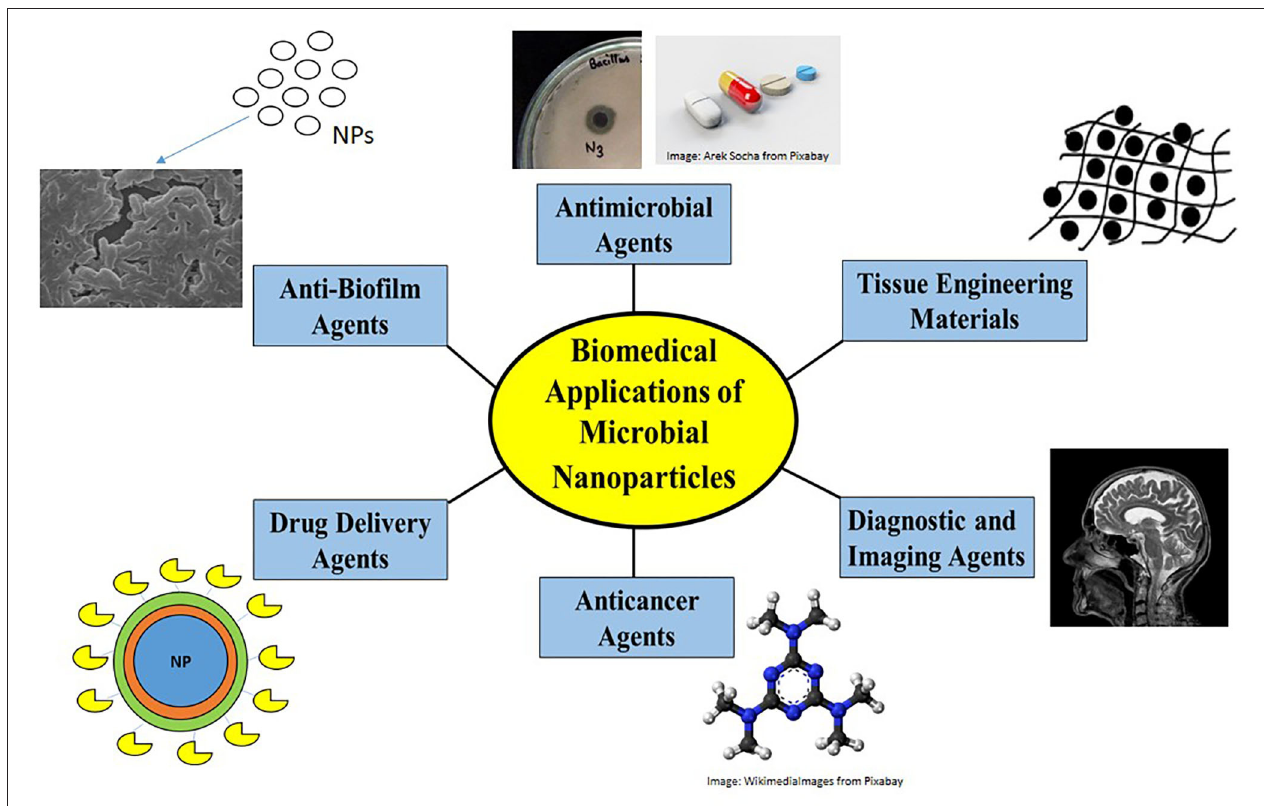
FIGURE 3 | Biomedical applications of nanoparticles. Nanoparticles find biomedical applications as antimicrobial agents by disrupting membrane structure or by generating ROS, as anti-biofilm agents in preventing antimicrobial resistance, as drug-delivery agents to carry drug loads, as anti-cancer agents causing apoptosis, as diagnostic/imaging agents in MRI and biosensors and as anticoagulants/anthelmintics/tissue engineering